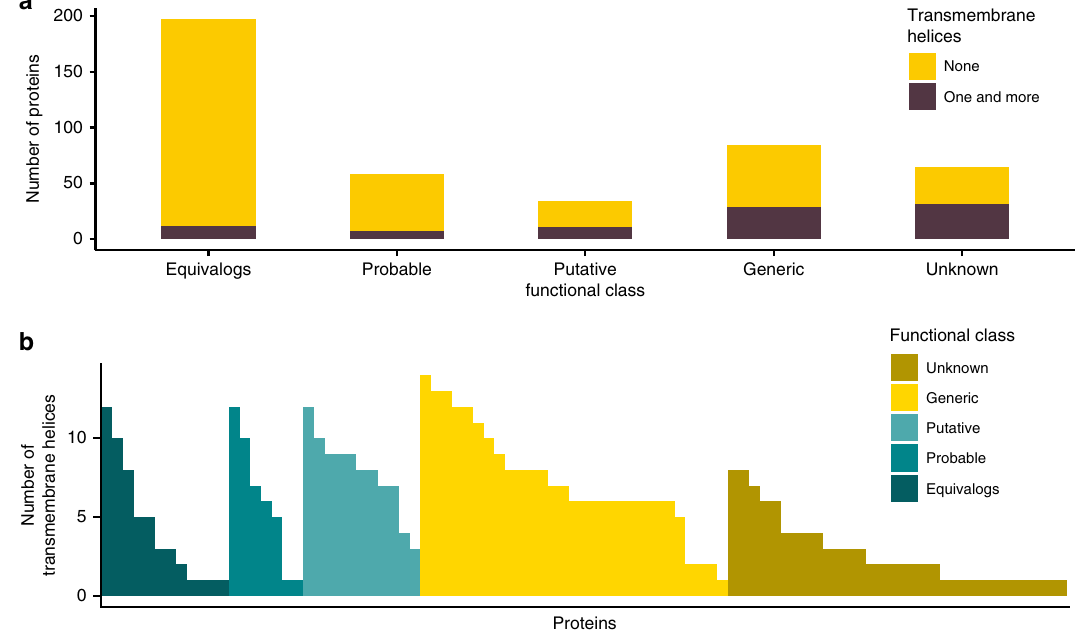
Fig. 2 Transmembrane proteins encoded by the minimal bacterial genome. a The number of proteins predicted by TMHMM to have transmembrane helices. Brown indicates proteins with one or more transmembrane helix. Yellow for those without transmembrane helices. b The number of transmembrane helices present in each of the proteins in the minimal genome that is predicted to have one or more transmembrane helix. Results for each functional class are represented by a different colour: gold for the Unknown class, yellow – Generic, light turquoise – Putative, turquoise – Probable and